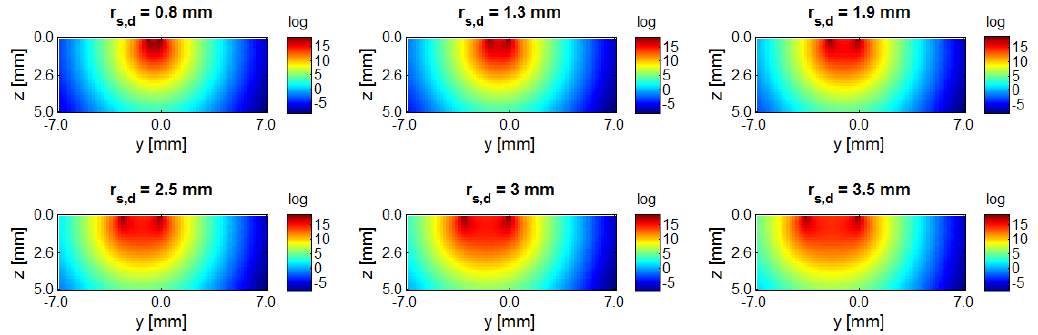
Figure 4. Cross section ( yOz , 0 x  ) of Monte Carlo computed sensitivity matrix for different source-detector